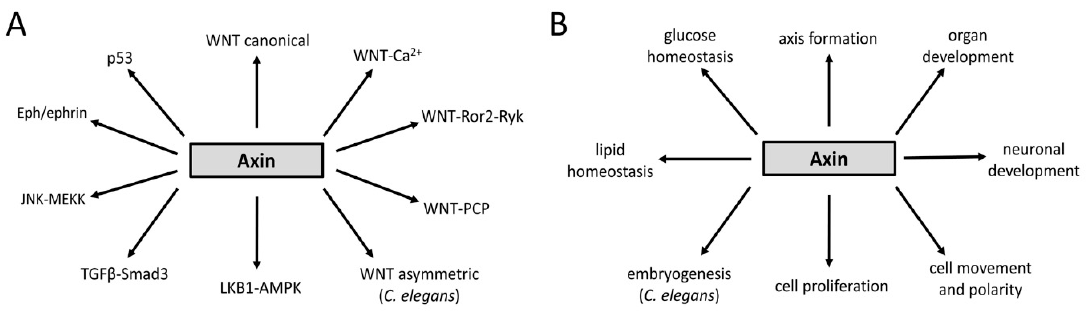
Figure 3. An overview of Axin’s involvement in multiple pathways ( A ) and processes ( B ), as described in this review.